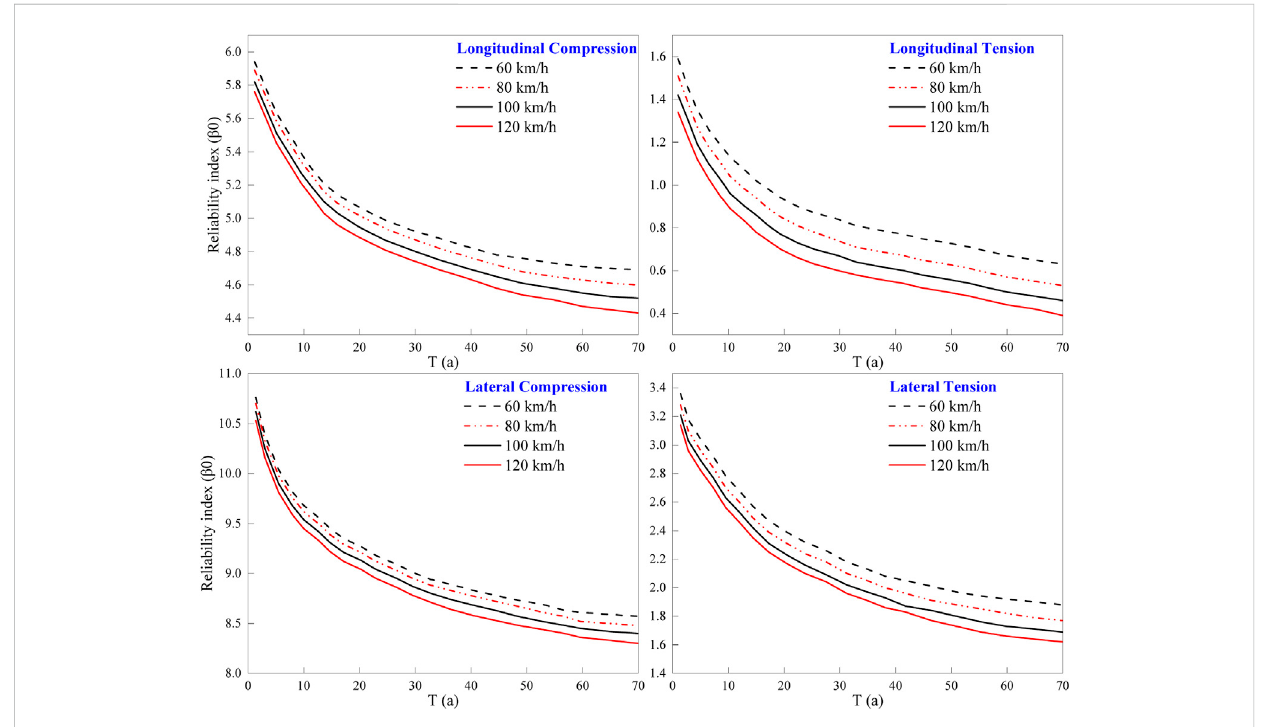
FIGURE 4 Effects of different train speeds on the fatigue reliability of the invert